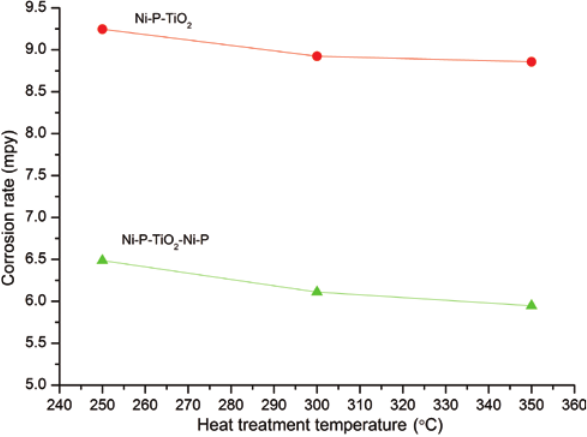
Figure 4 Effect of heat treatment temperature on the corrosion resistance of the Ni-P/TiO composite and multilayer 2